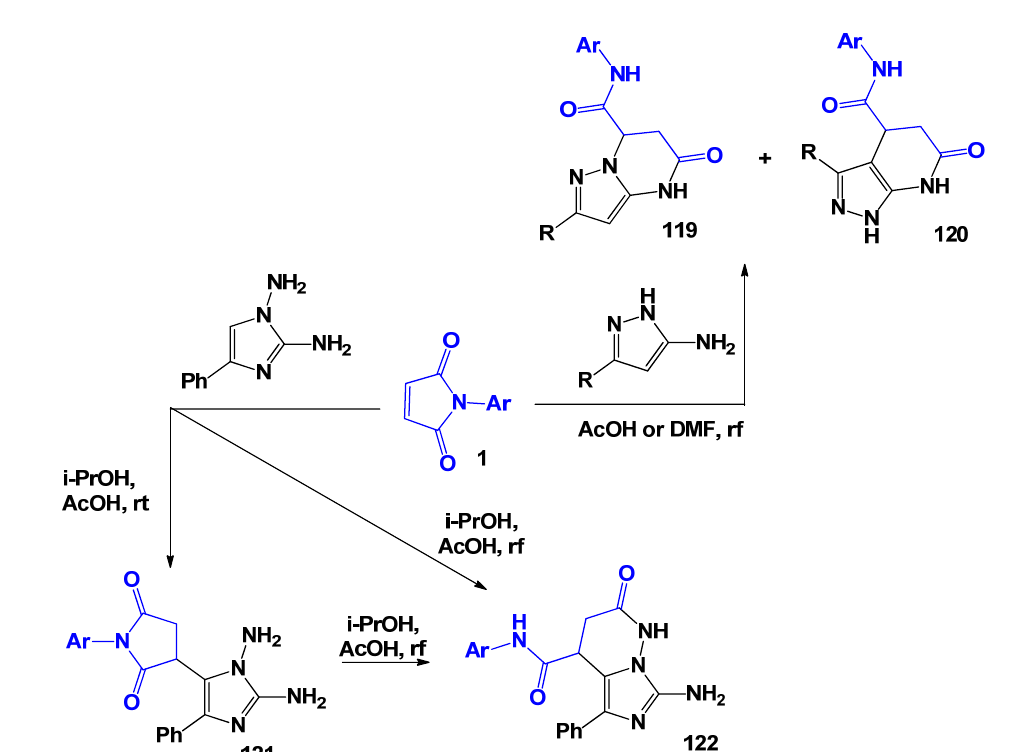
Molecules 2022 , 27 , x FOR PEER REVIEW Scheme 30. 5-Amino-3-R-pyrazoles and 1,2-diamino-4-phenylimidazole in recyclization reactions involving N -arylmaleimides.